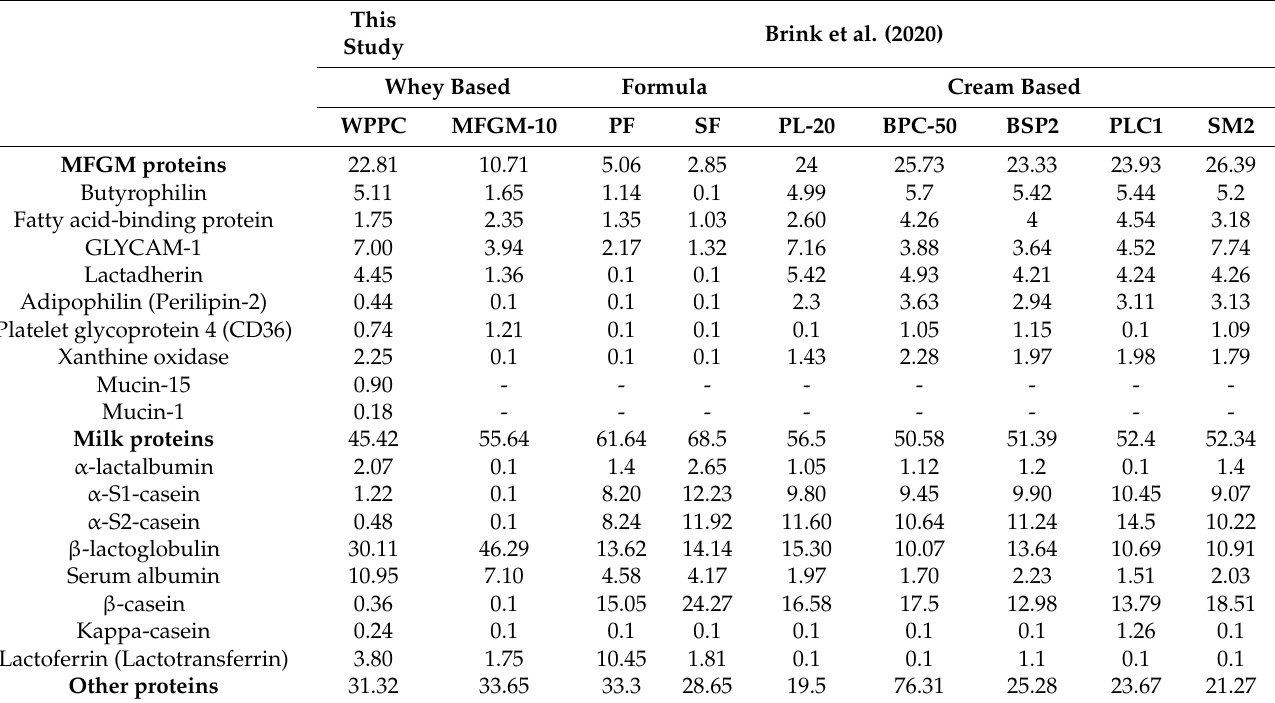
Table 2. Comparative protein results in each sample expressed as the relative percentage of total and relative percentages of the milk fat globule membrane (MFGM), milk, other protein